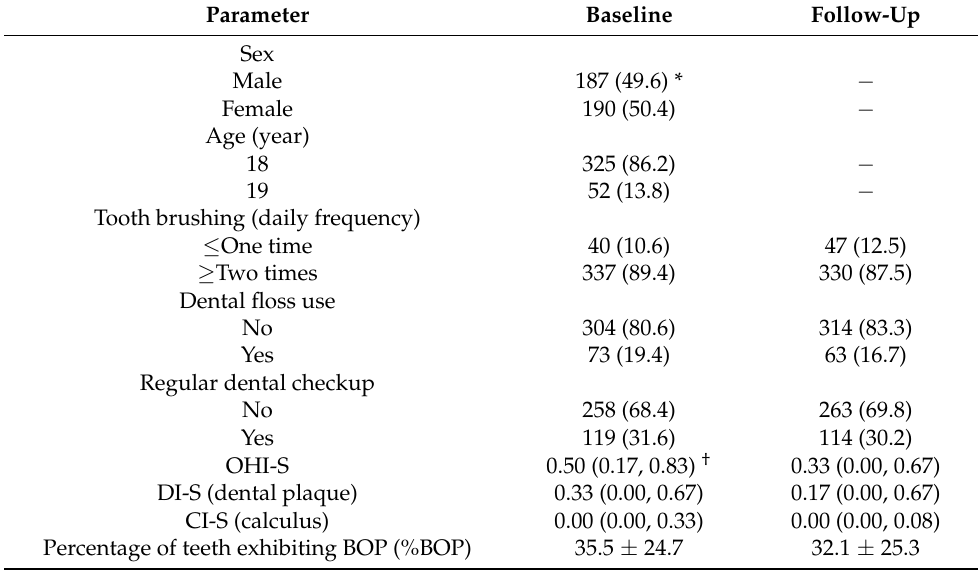
Figure 2. Flowchart of students included in analyses. Table 1. Participant characteristics (n = 377).